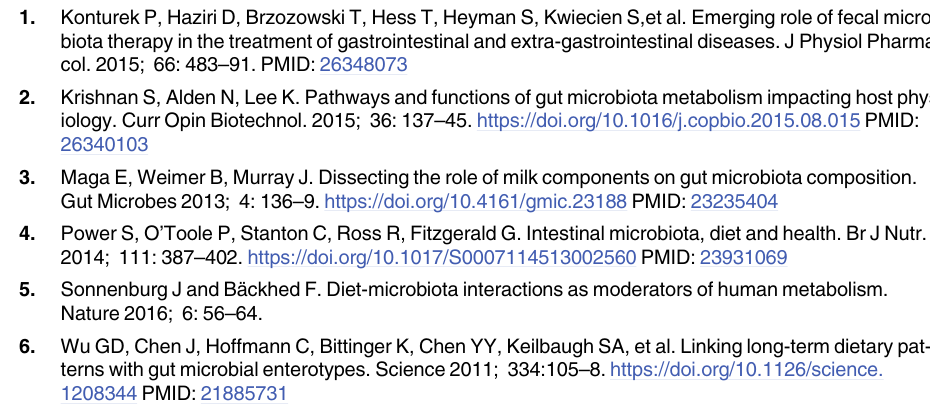
S1 Table. Average amount of SCFAs measured for each region during the experiment, pre- sented in mmol/L concentrations. S2 Table. 16S rRNA data: The community members for each sample were determined based on 16S rRNA gene sequencing, and grouped into indentified Operation Taxonomic Units (OTUs). In the table provided, the phylogeny for each OTU is listed on the left, and the percent relative abundance for each OTU in the samples sequenced is given. S3 Table. GC_SCFA data: The short chain fatty acids (SCFAs) were quantified for each sample using GC/MS. In the table provided, the SCFA measurements for each sample are given, as well as the ratio of Acetate:Propionate:Butyrate for each sample.